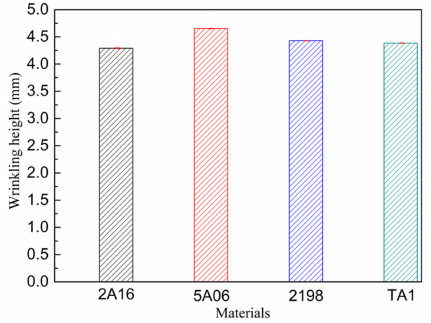
Figure 24. Maximum wrinkling height distributions of di ff erent